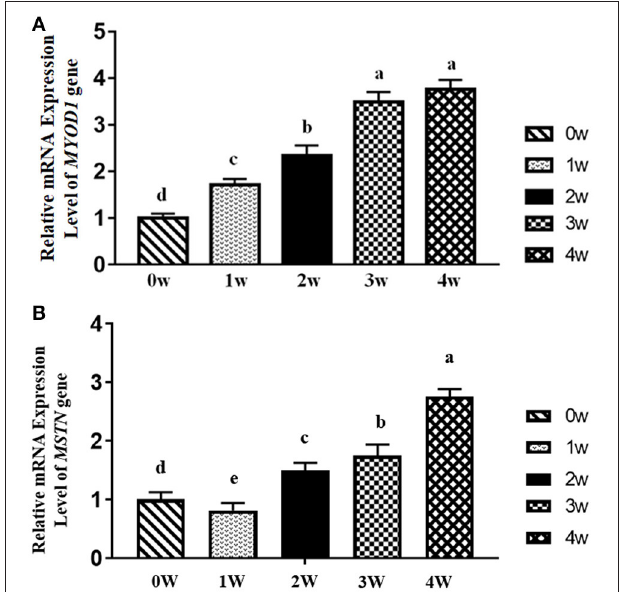
FIGURE 4 | Relative mRNA expression levels of myogenic differentiation 1 (MYOD1) and myostatin (MSTN) gene in breast muscle of domestic pigeons at 0, 1, 2, 3, and 4 weeks post-hatching. β -actin was used as the reference gene. Bars with lowercase letters meant significant differences ( p < 0.05). Data were represented as mean SE for 10 pigeons ( n 10). (A) Relative ± = mRNA expression levels of MYOD1. Group 0 week was used as reference. (B) Relative mRNA expression levels of MSTN. Group 0 week was used as reference.